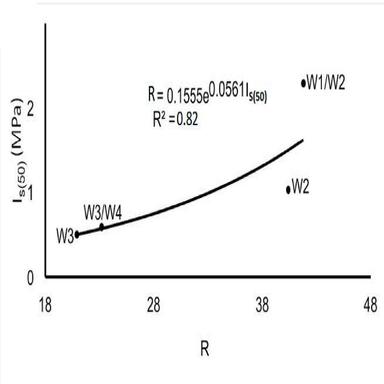
Correlation between IS(50) (perpendicular) and R (matrix hardness).